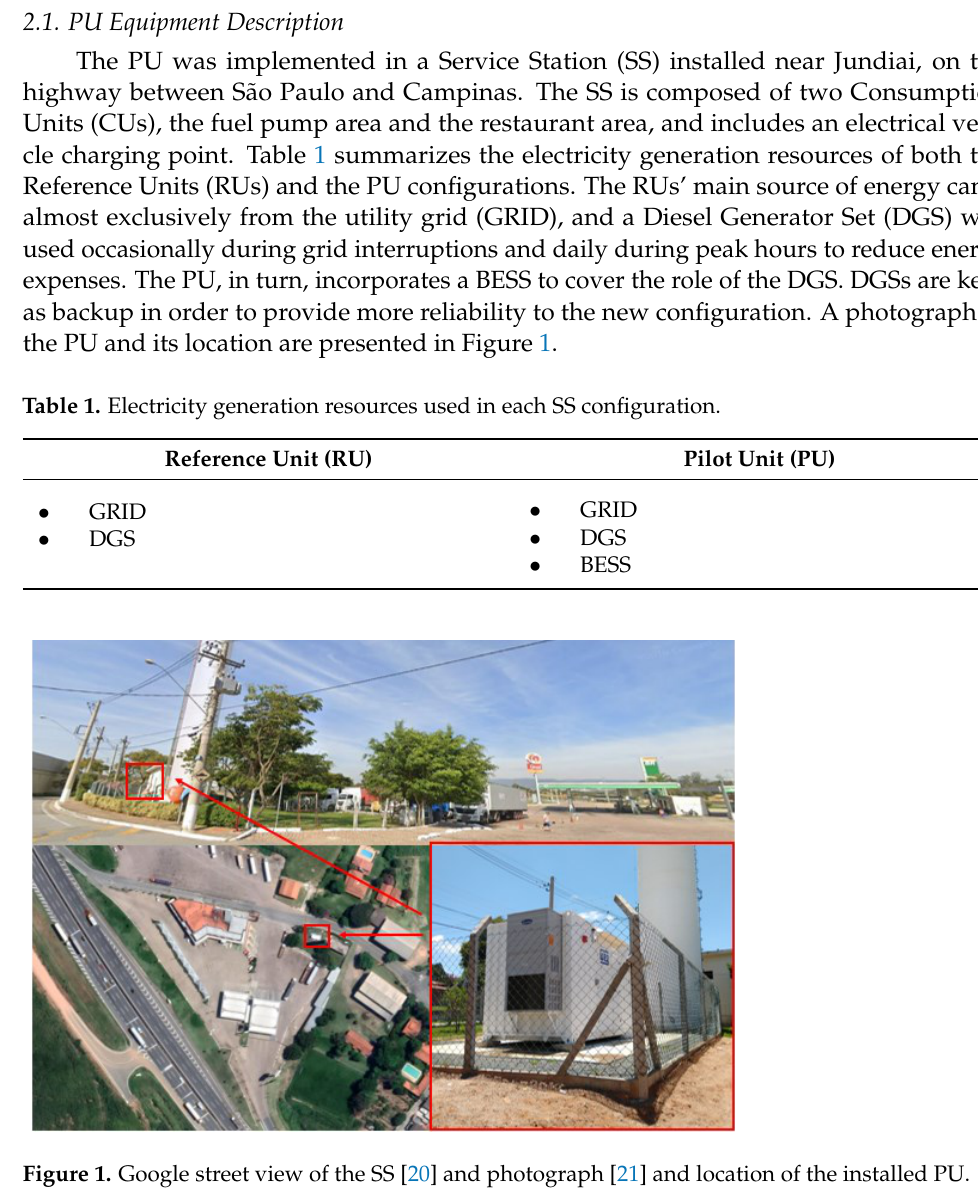
Figure 1. Google street view of the SS [20] and photograph [21] and location of the installed